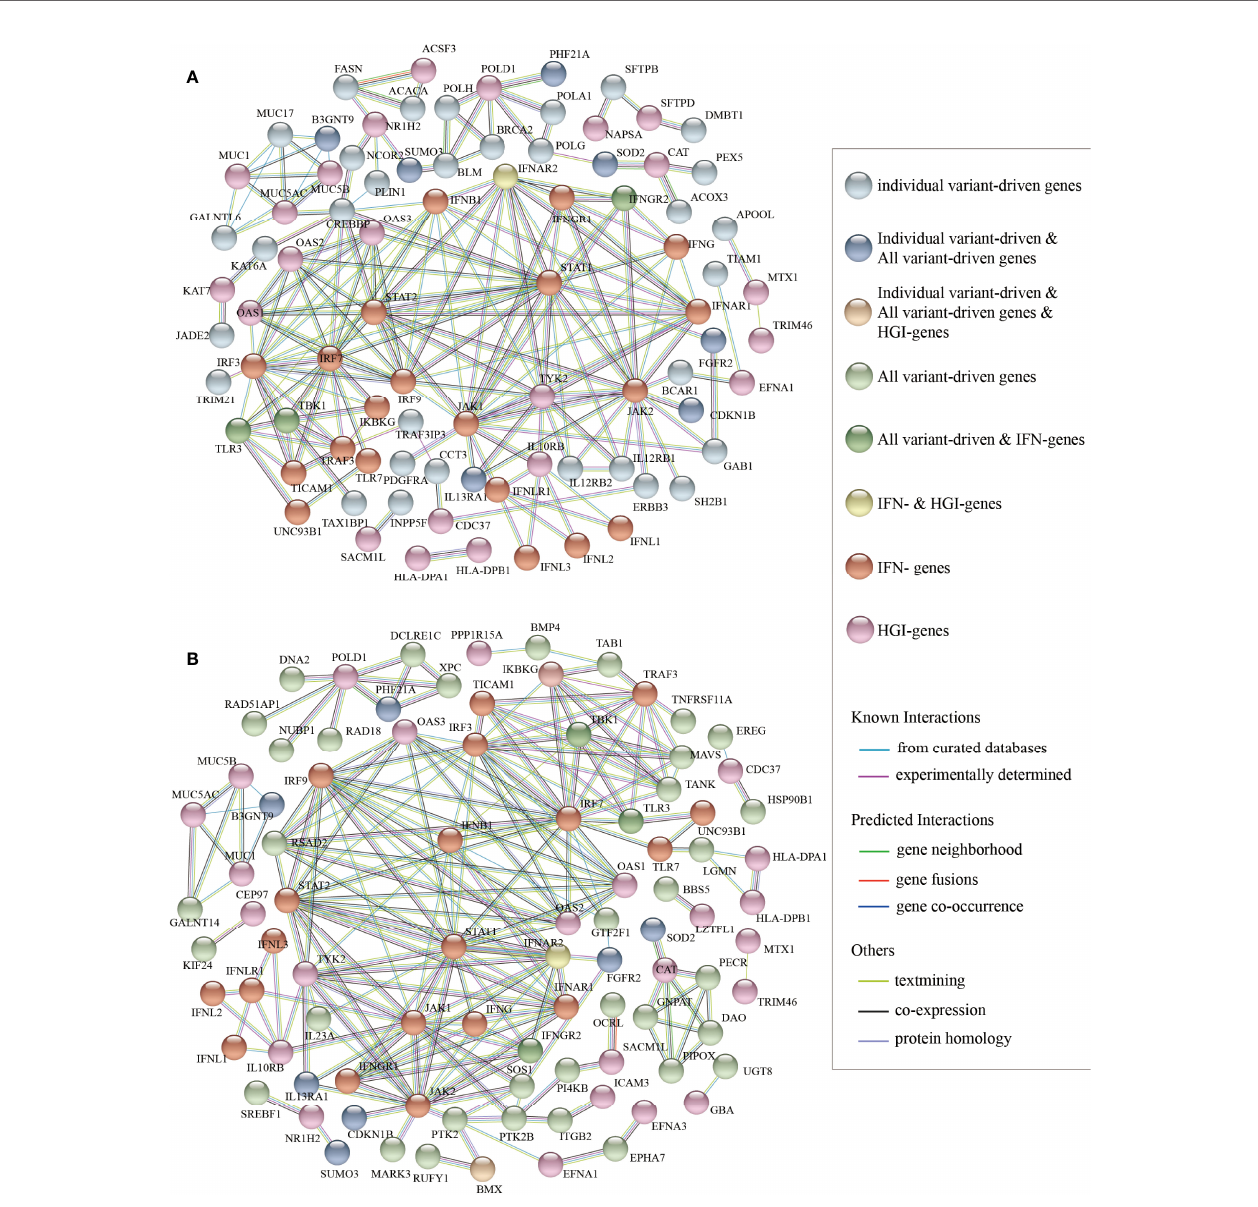
FIGURE 3 | The results of protein-protein interaction network analysis. The plot of the PPI network (A) between the “ individual variant-driven ” genes with the candidate genes, and (B) between the “ all variant-driven ” genes with the candidate